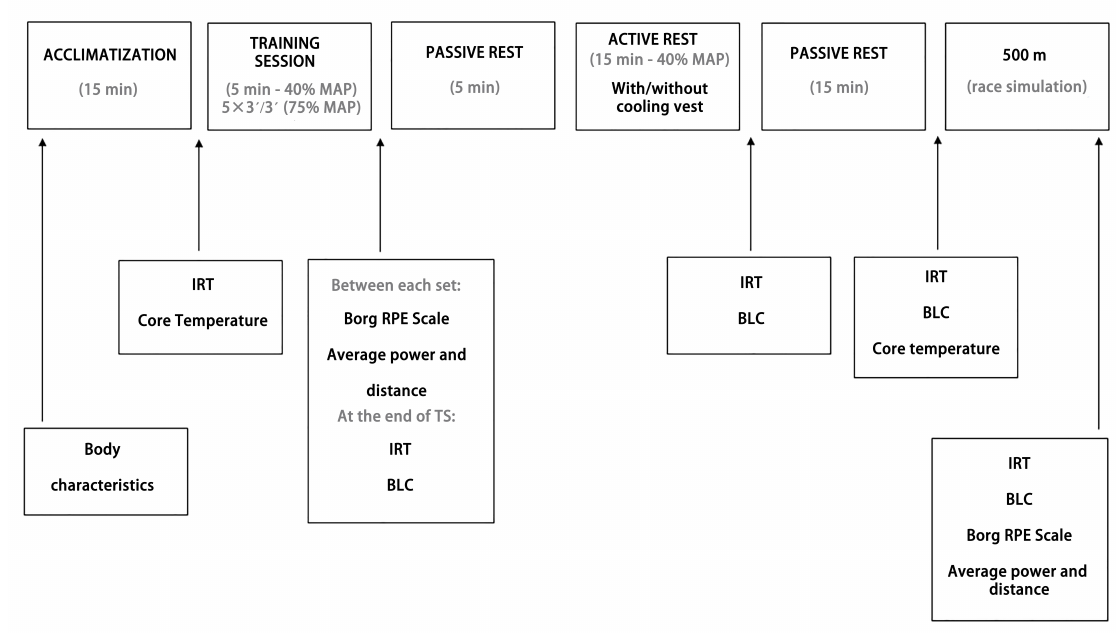
Fig. 1. Study’s protocol: expressing the procedures and the assessments made in each phase. IRT, infrared thermography; BLC, blood lactate concentration; TS, training